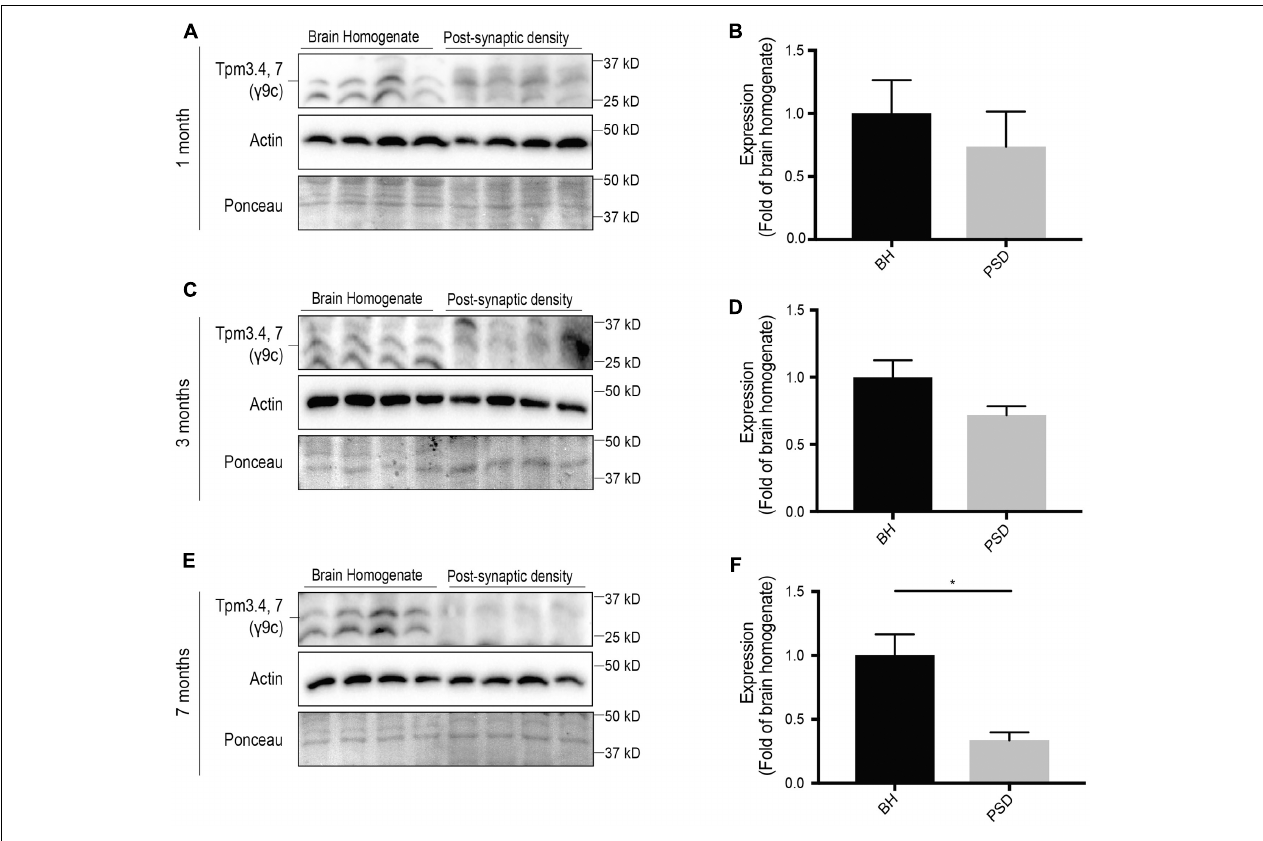
FIGURE 6 | Expression profile of Tpm3 exon 9c-containing tropomyosin (Tpm) isoforms utilizing the γ 9c sheep polyclonal antibody in the brain homogenate (BH) and post-synaptic density (PSD) of wild type mouse brains. (A) Western blot of 1-month-old brain homogenate and PSD fractions. (B) Quantification of (A) normalized to expression in the brain homogenate. (C) Western blot of 3-months-old brain homogenate and PSD fractions. (D) Quantification of (C) normalized to expression in the brain homogenate. (E) Western blot of 7-months-old brain homogenate and PSD fractions. (F) Quantification of (E) normalized to expression in the brain homogenate. Total actin and Ponceau staining are used as loading controls. (mean ± SEM, n = 4, ∗ P <